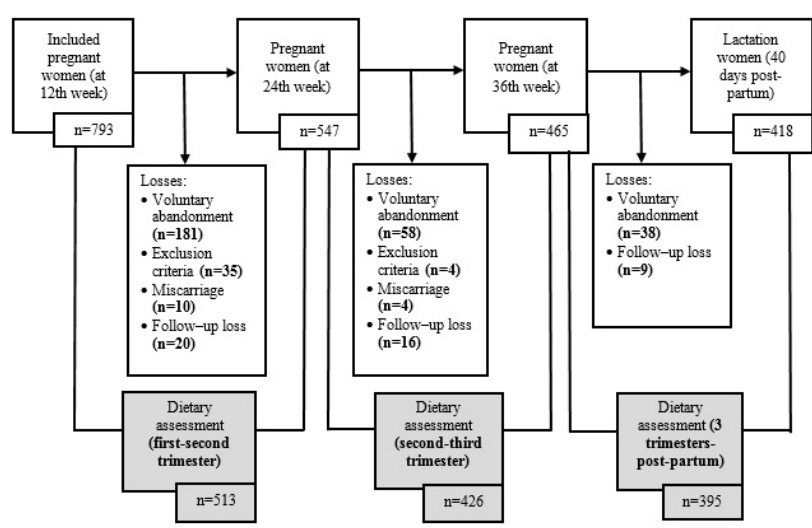
Figure 1. Flowchart of study participants with completed food data.